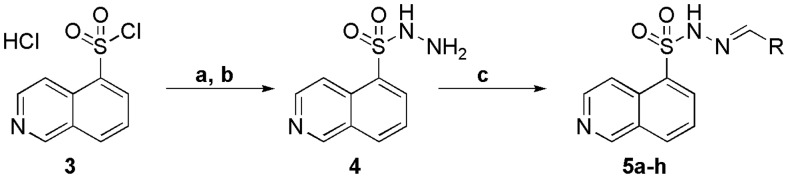
Synthetic route exploited to prepare the N-sulphonylhydrazones (5a–h). a) NaHCO3 aqueous, dichloromethane; b) N2H4.H2O, dichloromethane, 0 °C, 4 h, 80%; c) EtOH, HCI (cat), r.t., 24 h, 70–90%.